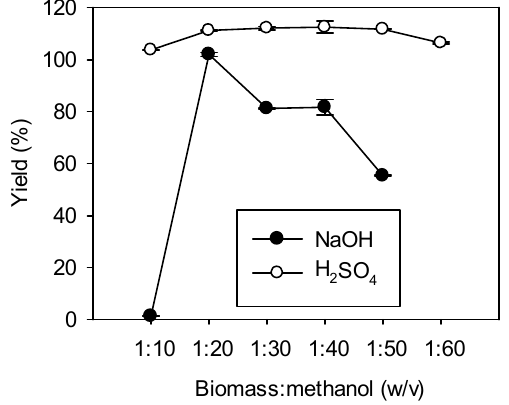
Figure 3. The effect of methanol loading on transesterification. Direct transesterification on 1 g of dry R. glutinis biomass was carried out at 70 °C with 1 g/L NaOH and 0.6 M H 2 SO 4 for 10 and 20 h, respectively. Data were obtained by averaging three individual measurements and the standard deviations were indicated with error bars.